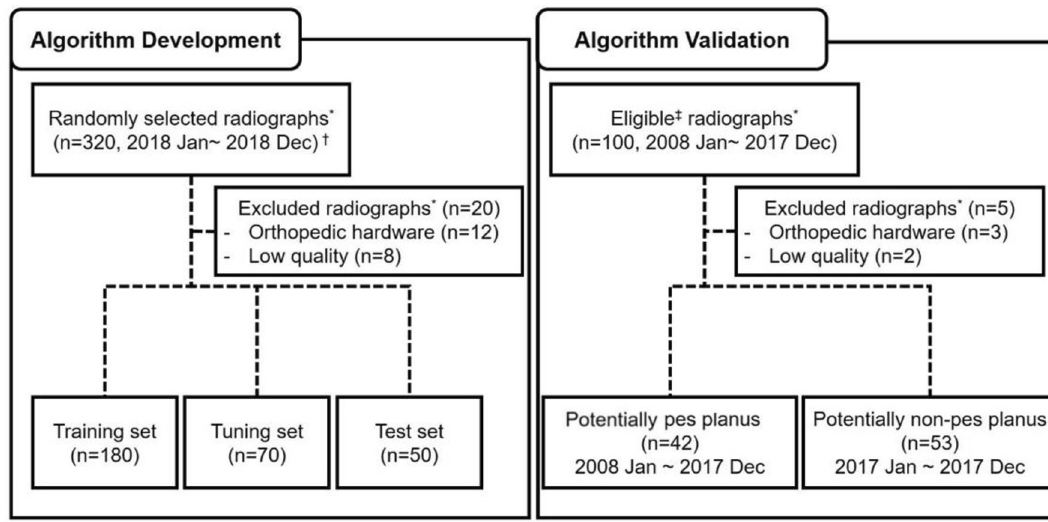
Figure 1. Flowchart of the study dataset assignment. *Weightbearing foot Lateral radiographs. † Time period of image acquisition did not overlap among training, tuning, and test sets. ‡ Radiographs from patients who